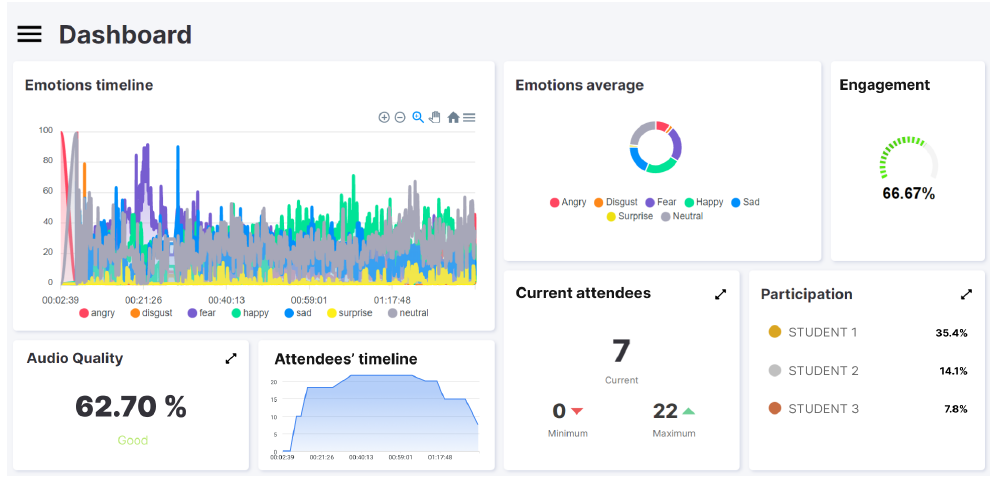
Figure 4. Software prototype, hands-on